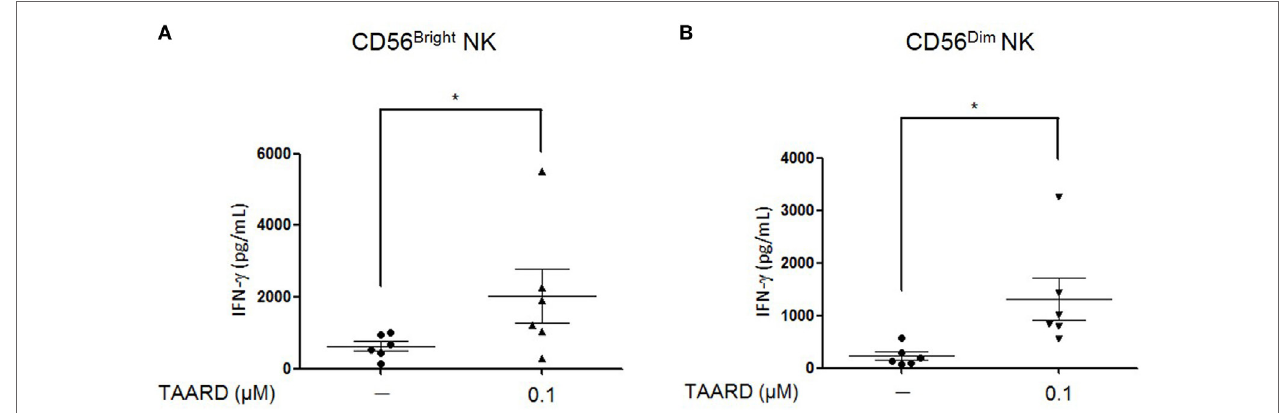
FigUre 2 | TAARD treatment augments interferon (IFN)- γ secretion by both CD56 bright and CD56 dim natural killer (NK) cells. Enriched NK cells were sorted via FACS into CD56 dim and CD56 bright NK cells, based on the relative density of CD56 expressed on the cell surface. (a) CD56 bright NK cells were treated with or without 0.1 µM of TAARD for 18 h in the absence of cytokine stimulation. IFN- γ secretion was determined by ELISA. (B) CD56 dim NK cells were treated and analyzed as shown in (a) . Data shown are collected from six donors. * p < 0.05 compared to the untreated